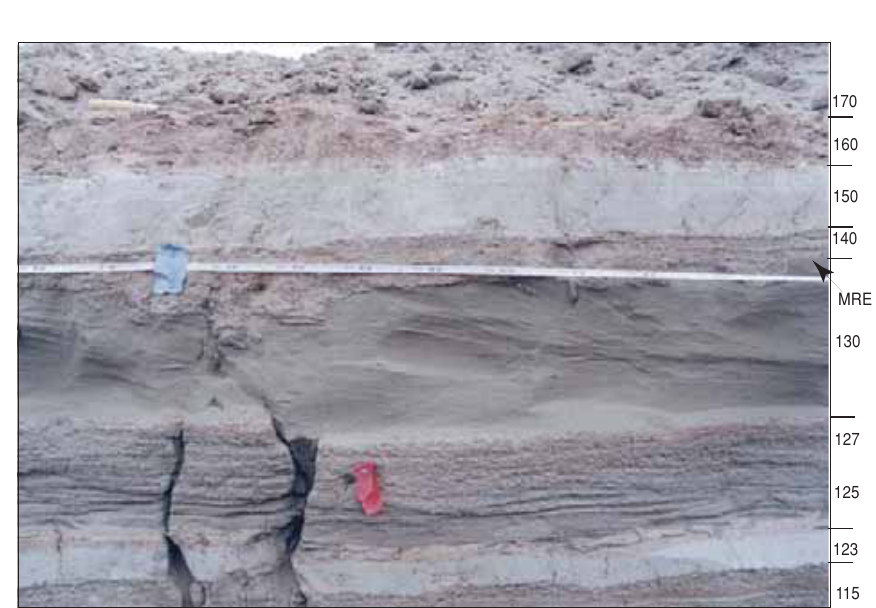
Fig. 6. Photograph of fault zone 1 on east wall of Camel trench (fig. 9). Note the metric tape measure on the trench wall for scale. Photograph shows, from top to bottom, units 170, 160, 150, 140, 130 (thick crossbedded sand), 127, 125, 123, and 115. Note that the faults have upward terminations between the top of unit 130 and the base of unit 150. This relationship shows rupture resulting from the last earthquake at the Camel